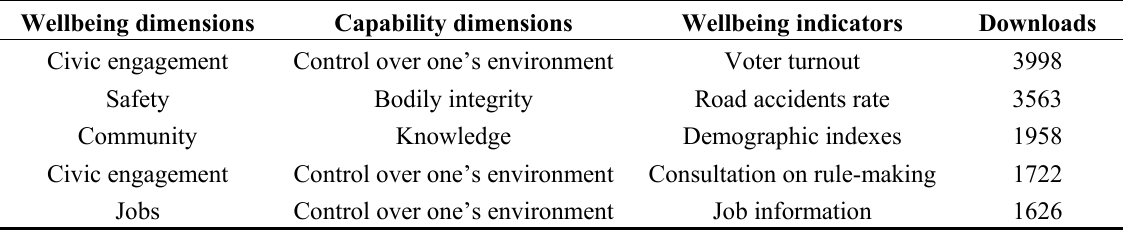
Table 5. “Downloads” of data sets for the “top five” triples of wellbeing-capability dimensions and wellbeing indicators